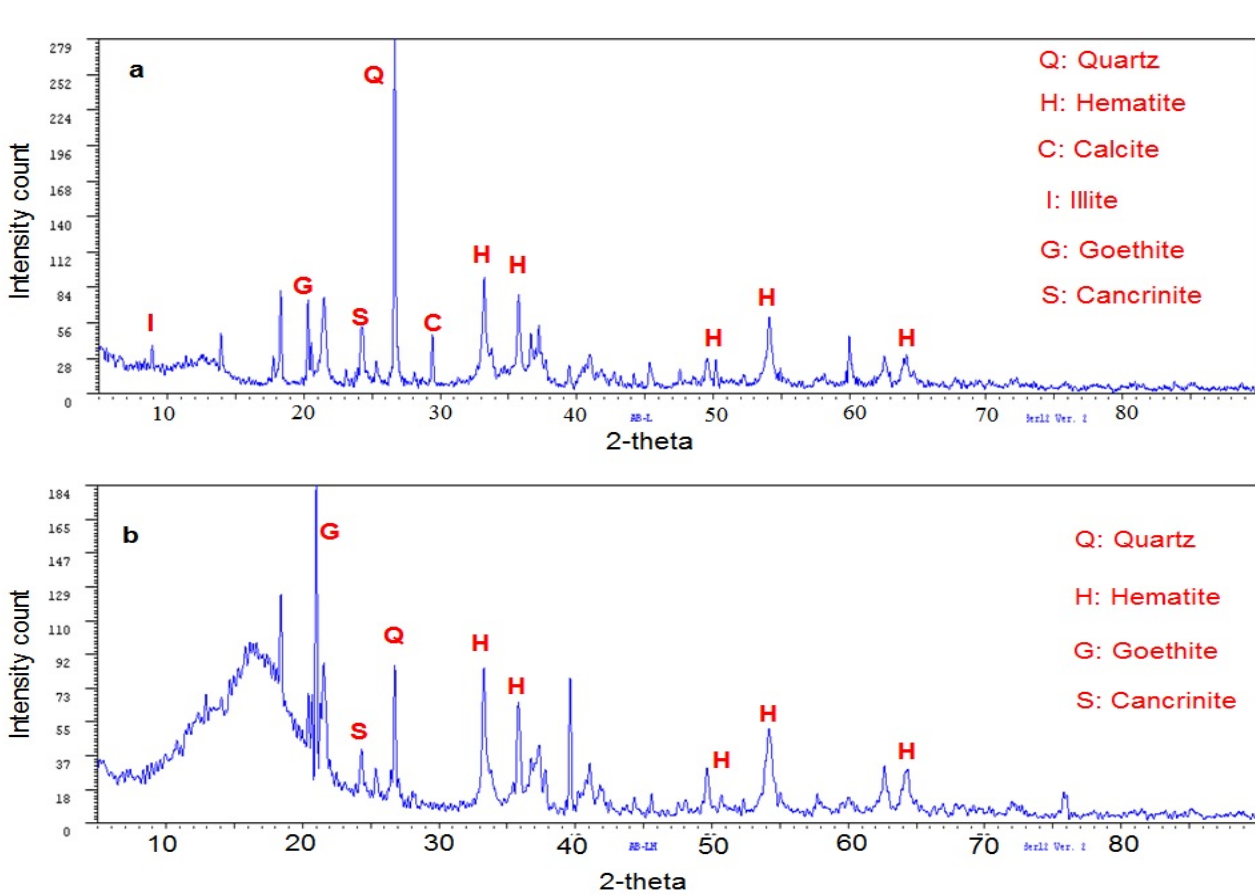
Figure 4. Diffractograms for red mud: ( a ) without modification, ( b ) modified with HCl.